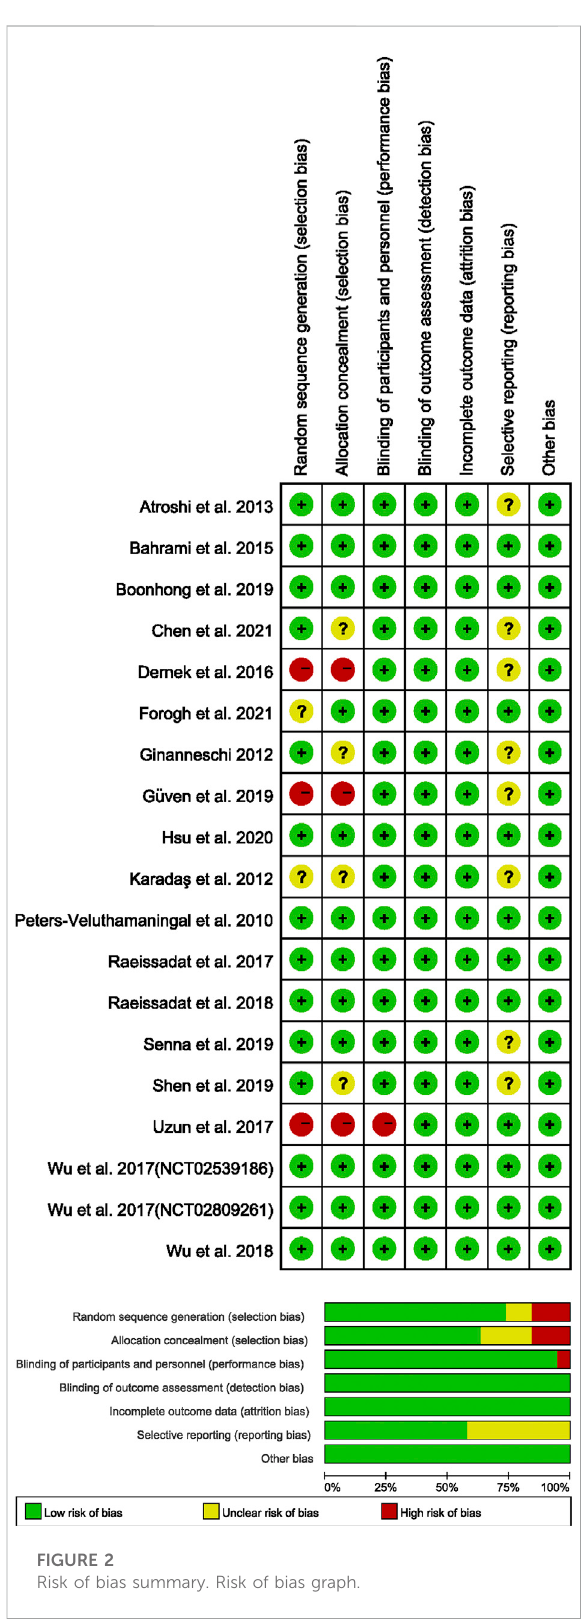
FIGURE 2 Risk of bias summary. Risk of bias